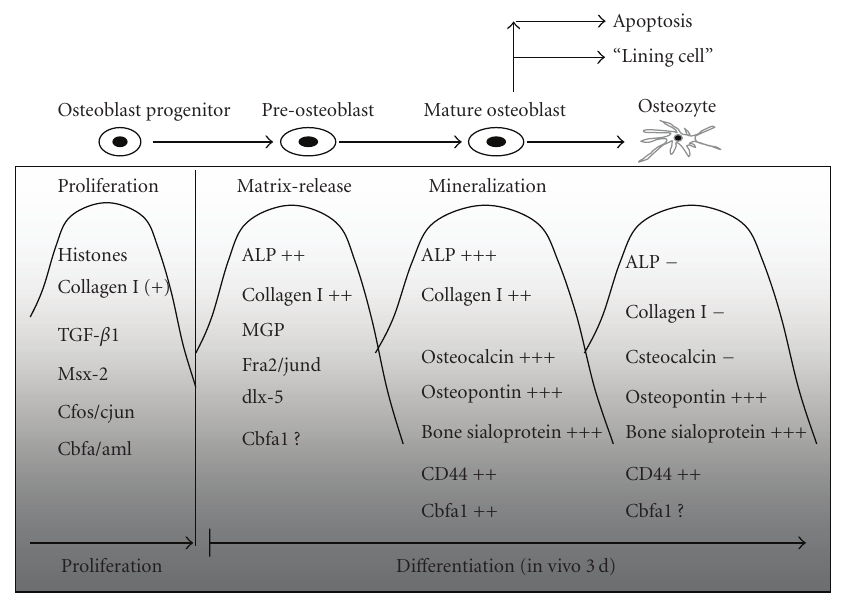
Figure 1: The di ff erentiation of osteoblast is characterized by di ff erent stages and lasts in vivo about 3 days. 50 to 70% of all osteoblasts undergo programed cell death (apoptosis) whereas the rest di ff erentiate into osteocytes or persistist as resting or bone-lining cells